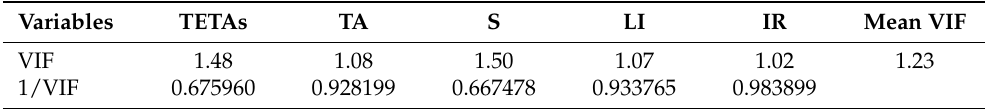
Table 9. VIF (Variance Inflation Factor) Results Obtained after Running TETAs on ROA and ROE OLS Model.